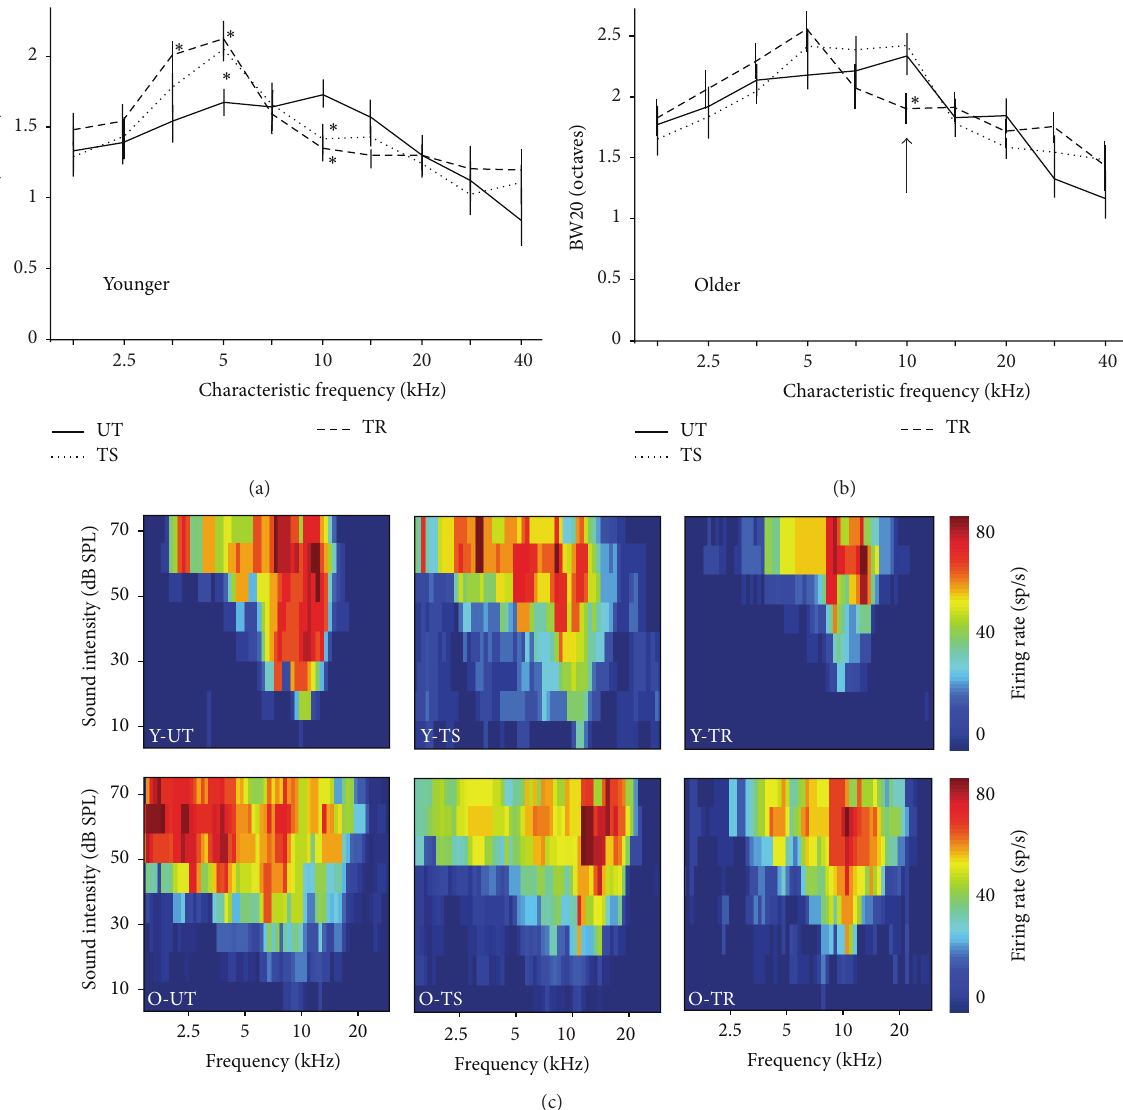
Figure 5: Changes in tuning bandwidth subsequent to training in the different experimental groups. ((a)-(b)) Average BW20 for all neurons recorded in young and older untrained (UT), trained with saline (TS), and trained with rivastigmine (TR) groups and separated by CF. Representative receptive fields of A1 neurons in the same experimental groups. The black arrows point to the lack of change in BW20 in the O-TS group compared to all other groups. (c) Representative tuning curves from each group for neurons with a CF of the nontarget tone (10kHz) that illustrate the narrowing of the bandwidth in all groups except the O-TS group (Y-UT: 𝑛 = 8 , recorded neurons = 189; Y-TS: 𝑛 = 5 , recorded neurons = 132; Y-TR: 𝑛 = 6 , recorded neurons = 157; O-UT: 𝑛 = 8 , recorded neurons = 201; O-TS: 𝑛 = 5 , recorded neurons = 138; O-TR: 𝑛 = 5 , recorded neurons = 117). Values shown are mean ± SE. ∗ 𝑝 < 0.05 : 𝑡